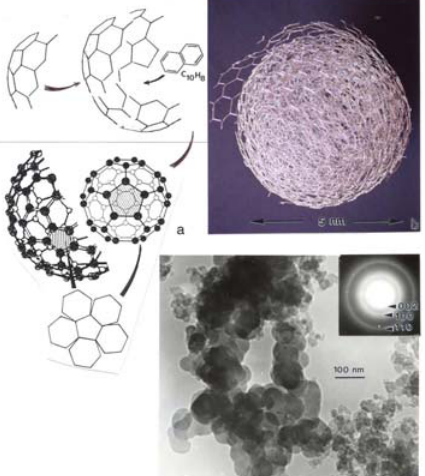
Figure 17: Soot formation (primary PM). (a) Clustering of curved graphene fragments (by the addition of at least 1, 5-member ring/pentagon) and intermixing of fullerenes , and intercalation of PAH isomers (such as such as C 60 naphthalene (C H )) to create carbonaceous, primary 10 8 spherules as shown in the wire model in (b). (c) shows clustering of primary spherules as in (b) to form complex, branched aggregates of BC observed in the TEM. The SAED pattern in (c) shows prominent graphite